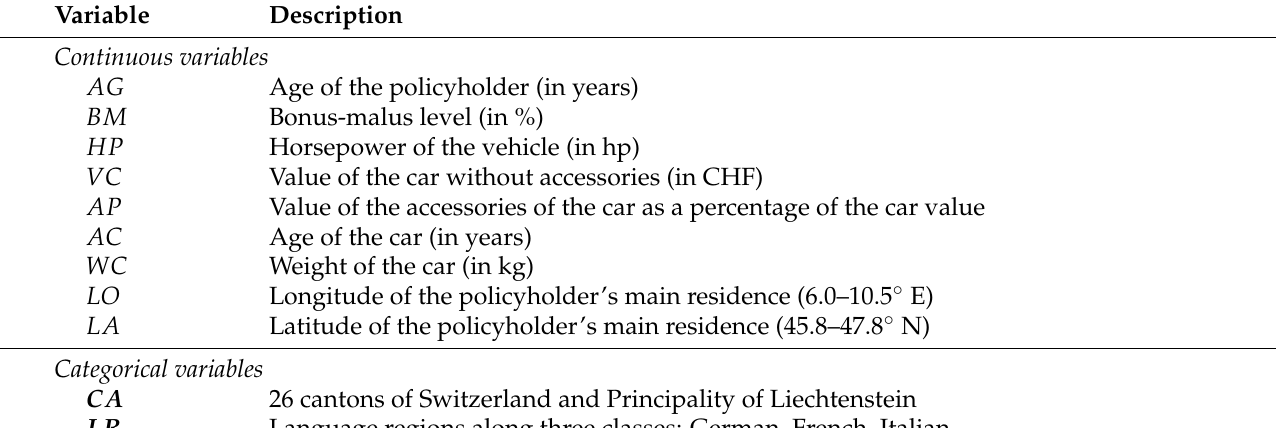
Table 1. Summary of the variables that are available in the